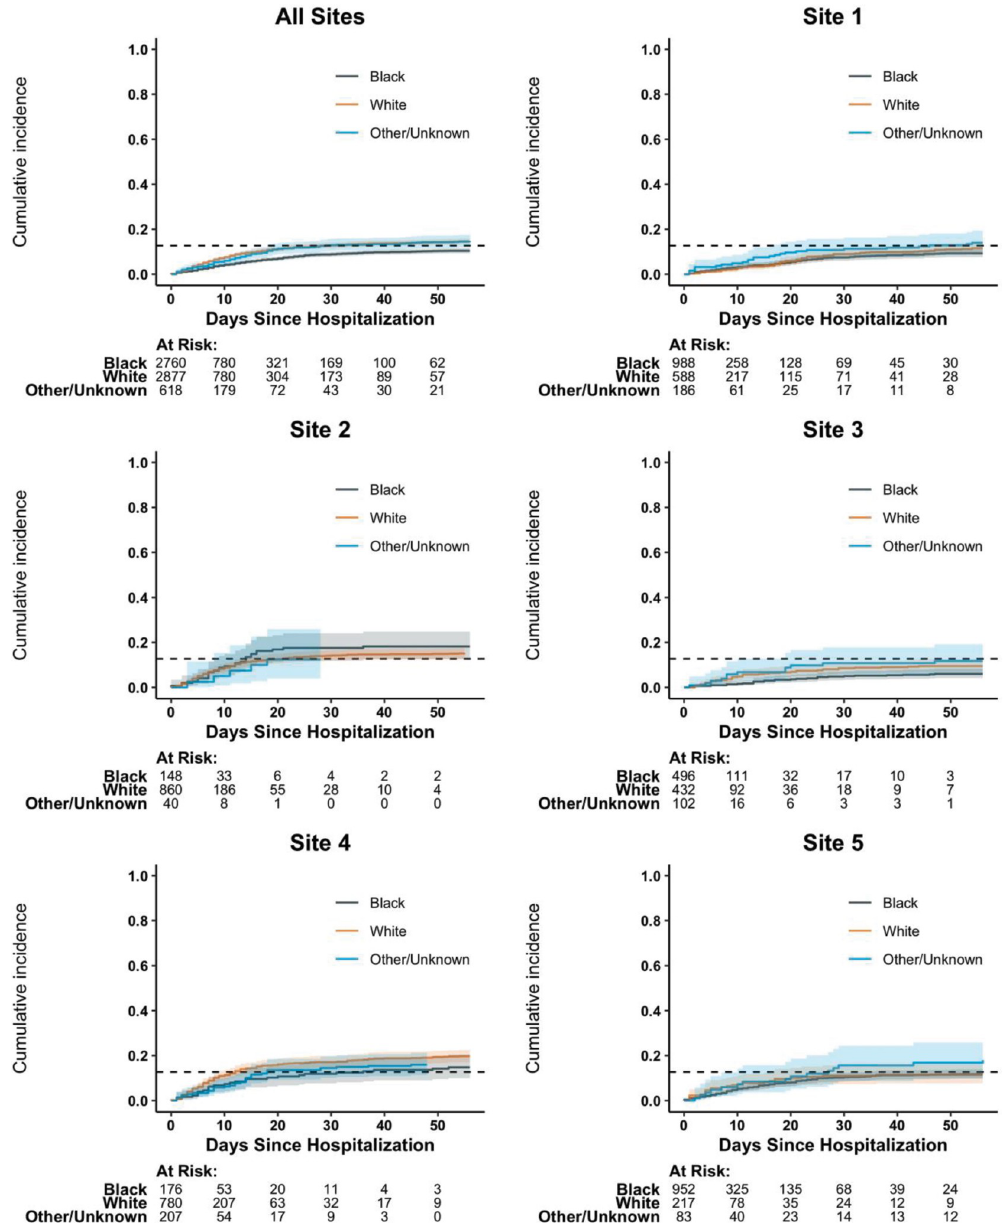
Fig 4. Cumulative incidence curves for death by admitting hospital and race. N = 6255; Site 1 (n = 1762), Site 2 (n = 1048), Site 3 (n = 1030), Site 4 (n = 1163), Site 5 (n = 1252) are unique hospitals in the University of Pennsylvania Health